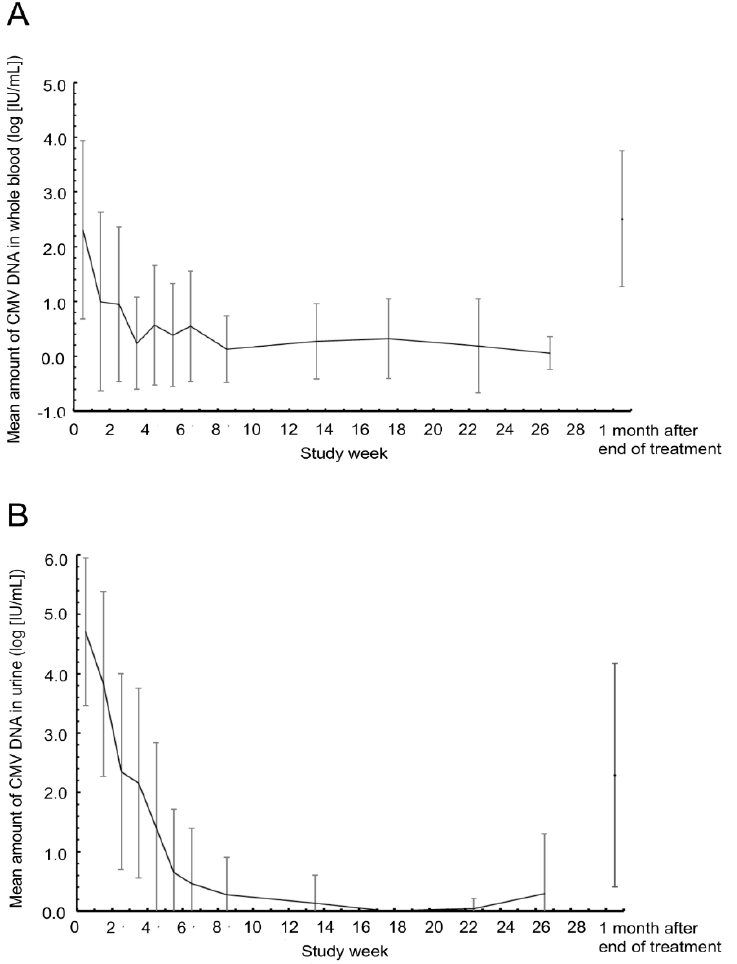
Figure 3. Dynamics of cytomegalovirus load in whole blood ( A ) and urine ( B ) over the study period. CMV, cytomegalovirus.